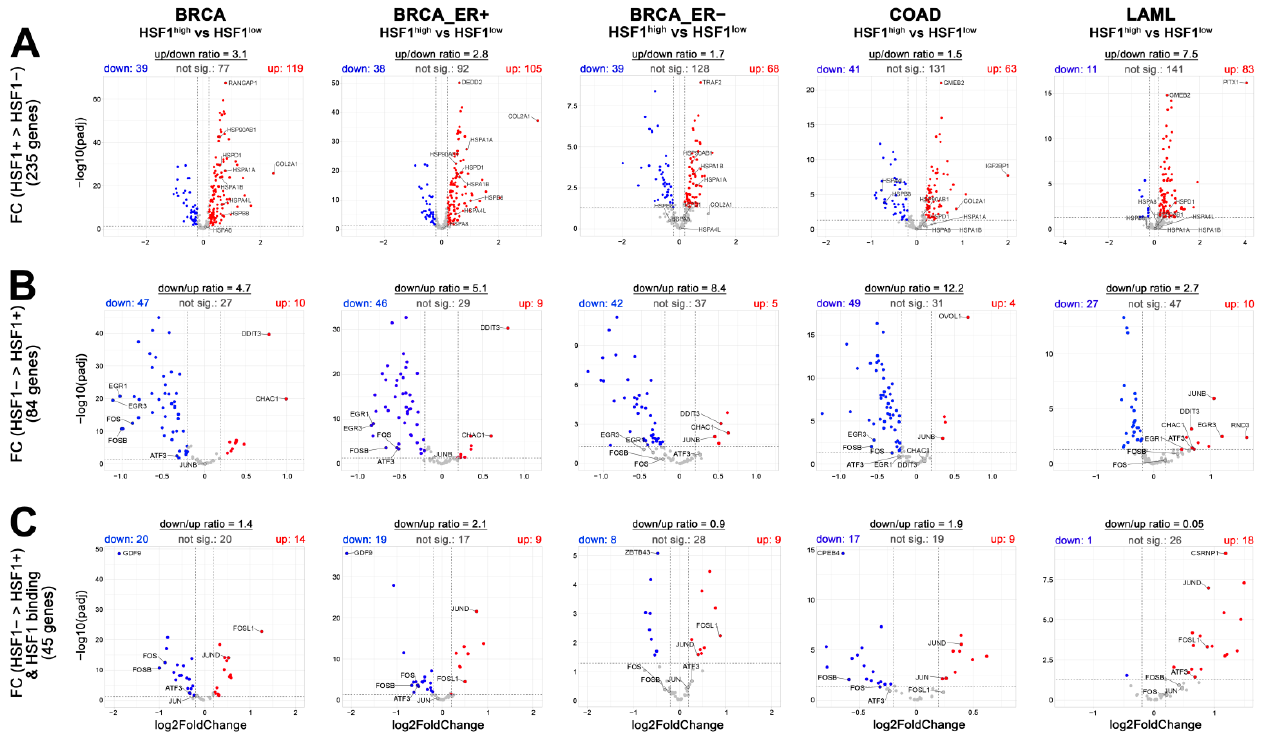
Figure 6. Differential expression analysis in human cancers with different levels of HSF1. Volcano plots comparing the expression of selected genes in BRCA (breast invasive carcinoma; ER+ and ER − , estrogen receptor-positive and negative, respectively), COAD (colon adenocarcinoma), and LAML (acute myeloid leukemia) cases with high and low HSF1 levels. Red/blue dots show genes with higher/lower expression in HSF1 high than in HSF1 low cancer cases. Signature of genes selected as dif- ferentiating the heat shock response in HSF1-proficient and HSF1-deficient MCF7 cells (shown in Figure 1C): ( A ) with higher fold change (FC) in HSF1 prof cells (expected to be up in volcano plots); ( B ) with higher fold change in HSF1 def cells (expected to be down in volcano plots). ( C ) Signature of HSF1 targets with higher fold change in HSF1 def cells.